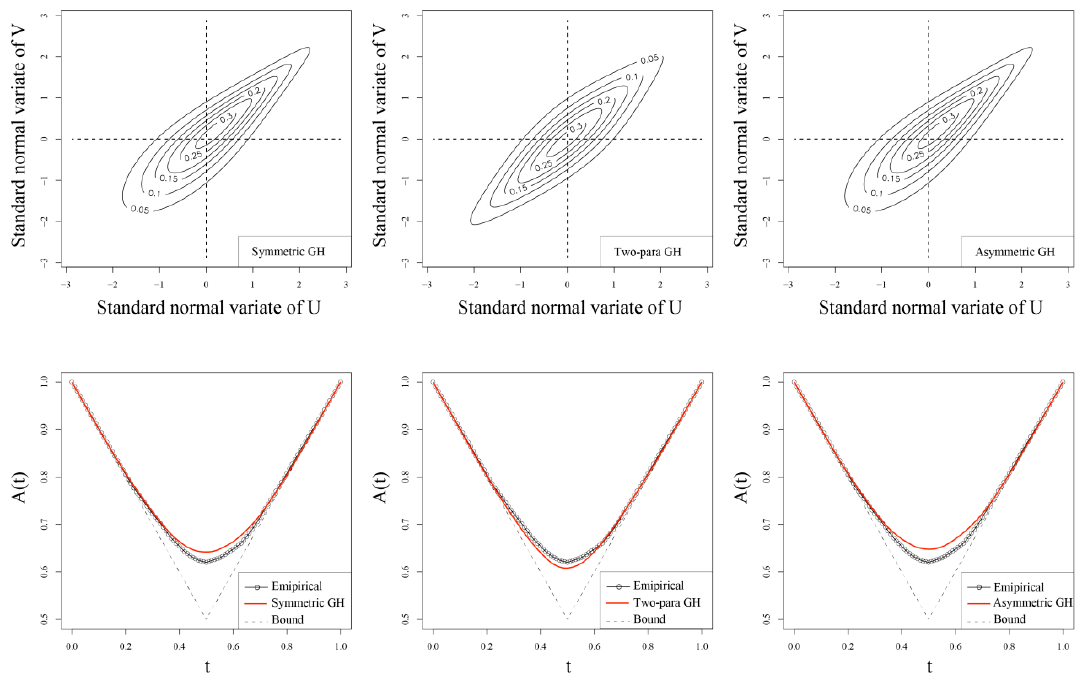
Figure 5. Contours of copula densities scaled to the standard normal distribution (N(0,1)) margins and plots of empirical Pickand’s dependence function compared with three fitted ones.